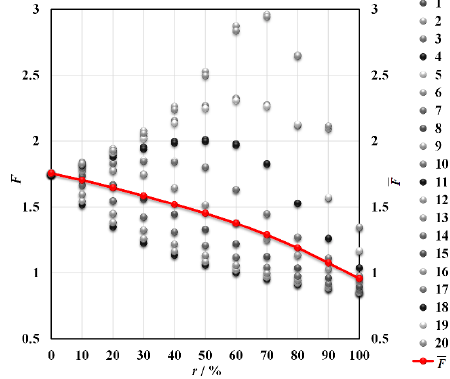
Figure 9. Evolution of dimensionless displacement r − λ and r − λ .